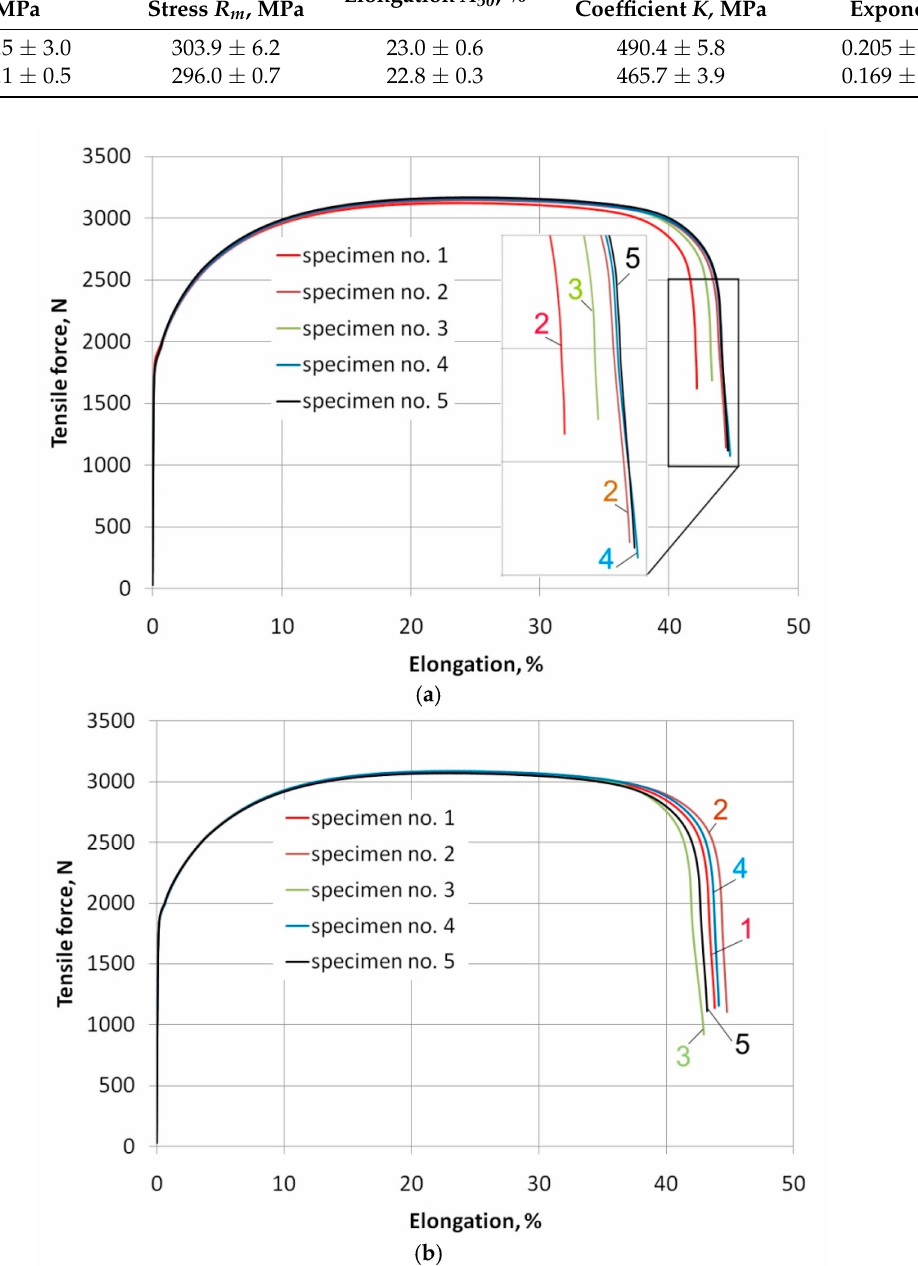
Figure 1. Load-elongation curves for specimens cut ( a ) parallel and ( b ) transversely to the sheet rolling